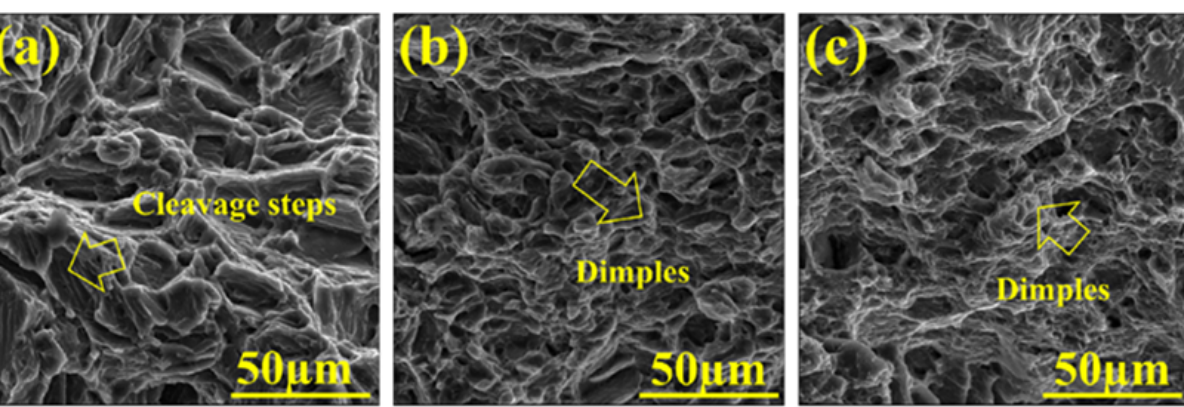
Figure 23: Tensile fracture images of as extruded (a) Mg–6Zn alloy, (b) Mg–6Zn–0.5GNP, and (c) Mg–6Zn–1.5GNP composites. Reproduced from Reference